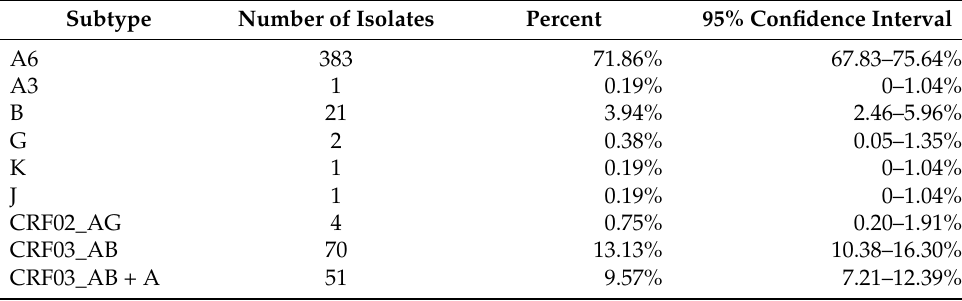
Table 1. Occurrence of HIV-1 subtypes in the studied